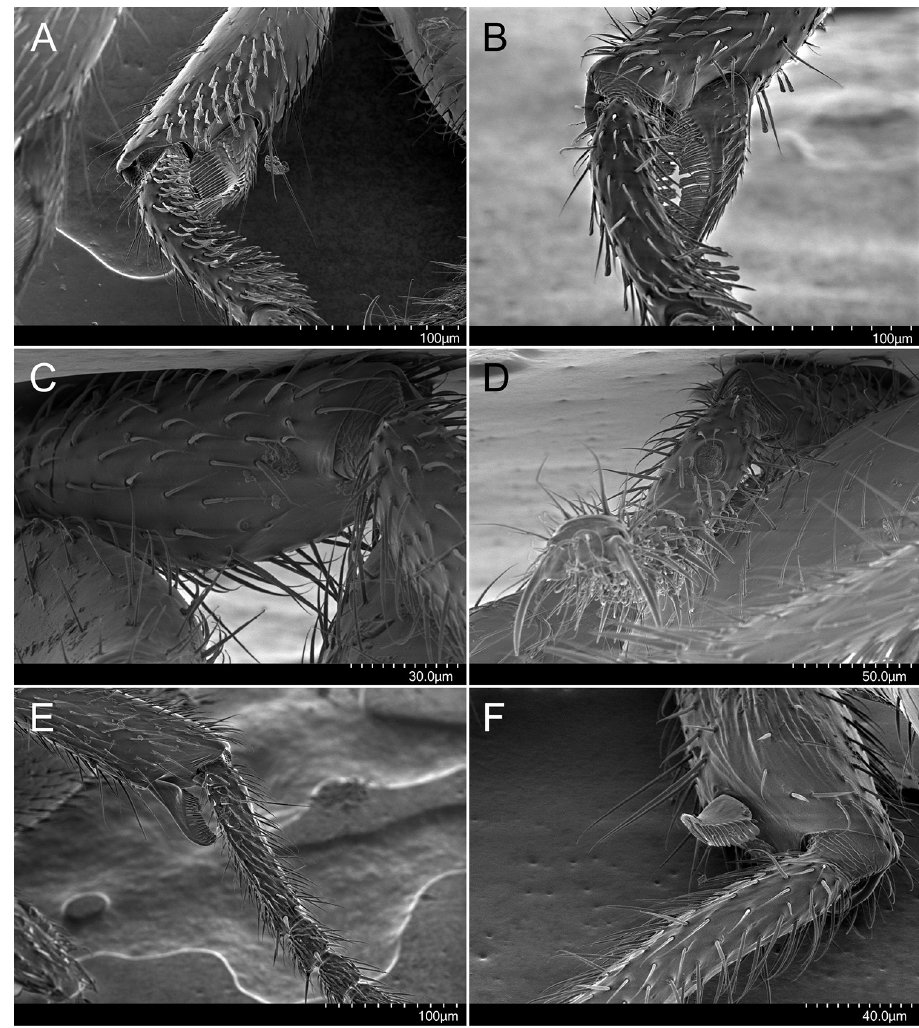
Figure 4. Holotype of Stigmatomma luyiae sp. n. (CASENT0922349); worker. Images by FAE; available at AntWeb.org. A Foreleg, anterior face. Close-up of the protibial apex, including the calcar of strigil, and probasitarsus B Foreleg, posterior face. Close-up of the protibial apex, including the calcar of strigil, and probasitarsus C Midleg, ventral face. Close-up of the mesotibial apex D Midleg, anterior face. Close-up of the mesobasitarsus, which bears a round sulcus filled with microvilli-like projections E Hindleg, anterior face. Close-up of the metatibial apex, including the metatibial spur, and metabasitarsus F Hindleg, posteri- or face. Close-up of the metatibial apex, including the metatibial spur, and basal portion of